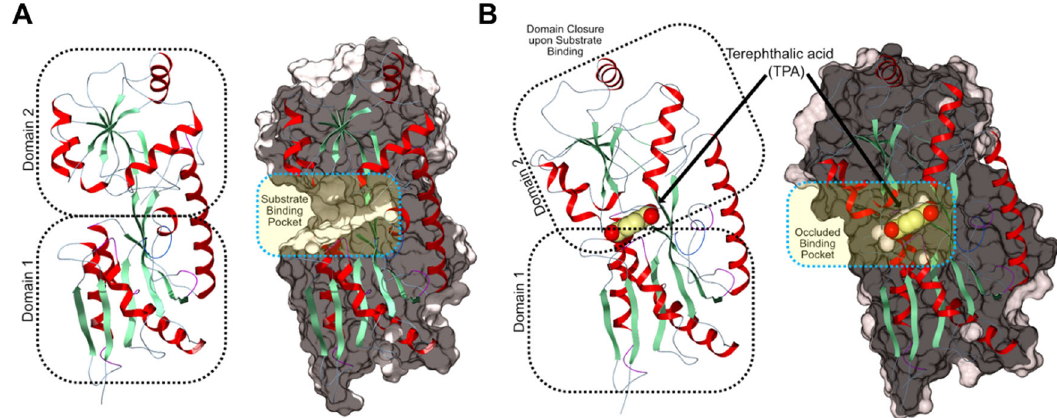
Fig. 4 Open and closed structure of the tripartite tricarboxylate transporter — solute binding protein TphC. A Crystal structure of TphC is shown in ribbon representation ( α -helices red, β -strands green), the structure is comprised of two domains with a large solvent accessible cleft located at the domain interface. A surface representation of the protein has been cut away to highlight the substrate-binding pocket. B Upon TPA binding (CPK sphere representation, all atom colours) the two domains reorientate to enclose the bound TPA. The cut away surface representation highlights the occluded pocket in which the TPA is bound.